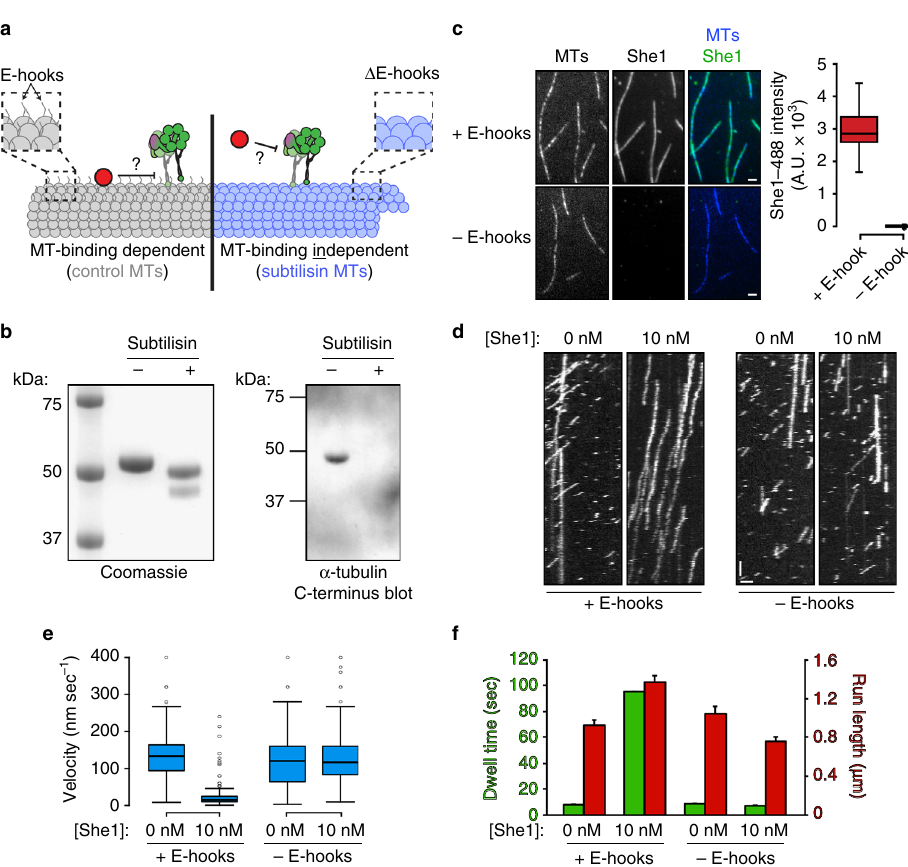
Fig. 3 Microtubule binding by She1 is required for it to affect dynein motility. a Schematic depicting two distinct mechanisms by which She1 may affect dynein motility. She1 either requires its microtubule-binding activity to affect dynein motility (left), or it affects dynein independently of its microtubule- binding activity (right). b Coomassie-stained SDS – polyacrylamide gel (left) and immunoblot (anti-alpha-tubulin-C-terminus; right) of taxol-stabilized HiLyte647-labeled microtubules incubated with or without subtilisin, as indicated (see Methods). c 10 nM She1-TMR was incubated with either control ( “ +E-hooks ” ) or subtilisin-digested ( “ − E-hooks ” ) coverslip-immobilized HiLyte647-labeled microtubules for 5 min, then images were acquired by TIRF microscopy. Representative fl uorescence images are shown (left) along with box plots of microtubule-bound She1-TMR fl uorescence intensity values (scale bars, 2 µ m). d Representative kymographs showing GST – dynein 331 motility in the absence or presence of 10 nM She1 on either control or subtilisin- digested microtubules. Note that for each experiment in which She1 is included, She1 was pre-incubated with the microtubules for 5 min before addition of GST – dynein 331 , which was diluted in motility mix that also included 10 nM She1 (horizontal scale bar, 2 µ m; vertical scale bar, 1 min). e Box plot of GST – dynein 331 velocity values in indicated conditions. f Mean run lengths (red) and dwell times (green) for GST – dynein 331 molecules along either control or subtilisin-digested microtubules in the absence or presence of She1 (error bars, standard error of the mean; n ≥ 199 individual motors for each condition). For box-whisker plots in c and e , whiskers de fi ne the range, boxes encompass 25th to 75th quartiles, lines depict the medians, and circles depict outlier values (de fi ned as values greater than (upper quartile + 1.5 × interquartile distance), or less than (lower quartile − 1.5 × interquartile